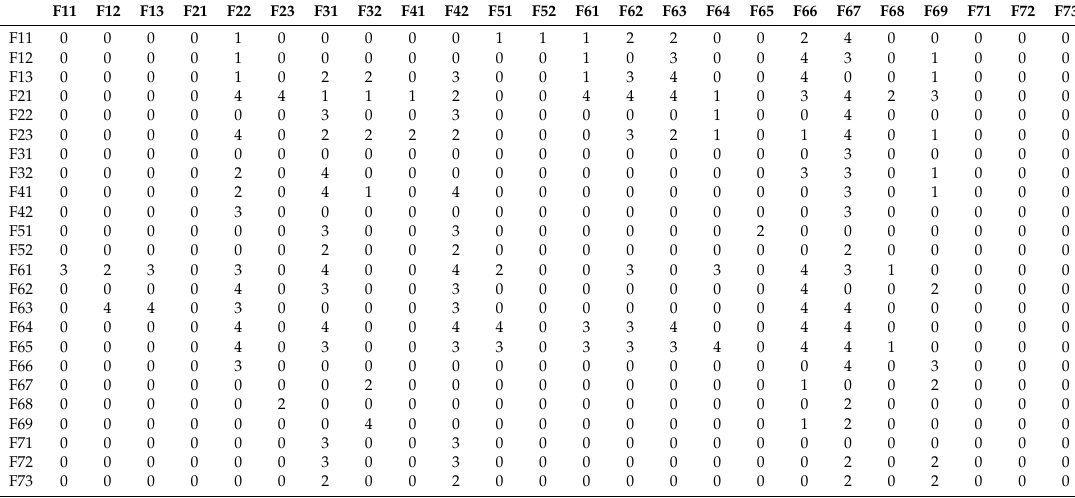
Table 4. Average direct-relation